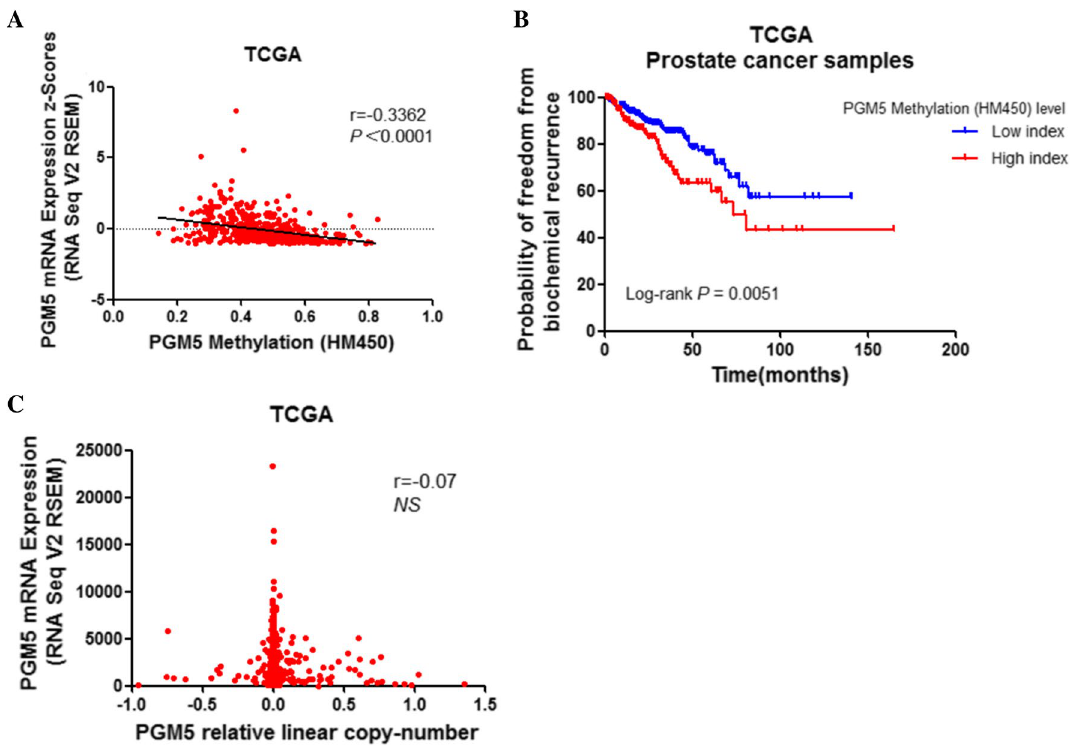
Fig. 5 PGM5 mRNA expression correlated with PGM5 promoter methylation level. A PGM5 mRNA expression is inversely correlated with PGM5 methylation level in prostate samples from TCGA dataset. B Kaplan–Meier survival curves for prostate cancer patients stratified by PGM5 methylation level. C PGM5 mRNA expression is not correlated with PGM5 copy number in prostate samples from TCGA